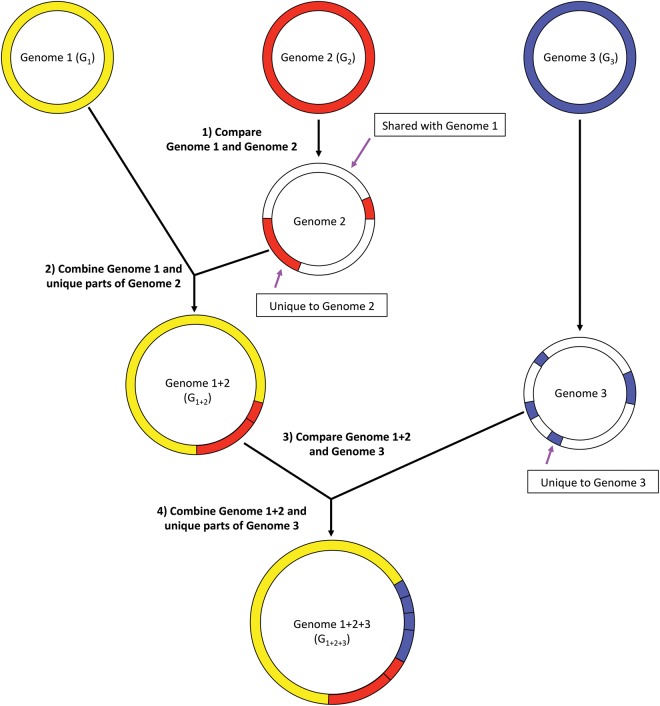
Compression of genome sequences before building the Centrifuge index. All genomes are compared and similarities are computed based on shared 53-mers. In the figure, genomes G1 and G2 are the most similar pair. Sequences of G2 that are ≥99% identical to G1 are discarded, and the remaining “unique” sequences from G2 are added to genome G1, creating a merged genome, G1+2. Similarity between all genomes is recomputed using the merged genomes. Sequences <99% identical in genome G3 are then added to the merged genome, creating genome G1+2+3. This process repeats for the entire Centrifuge database until each merged genome has no sequences ≥99% identical to any other genome.